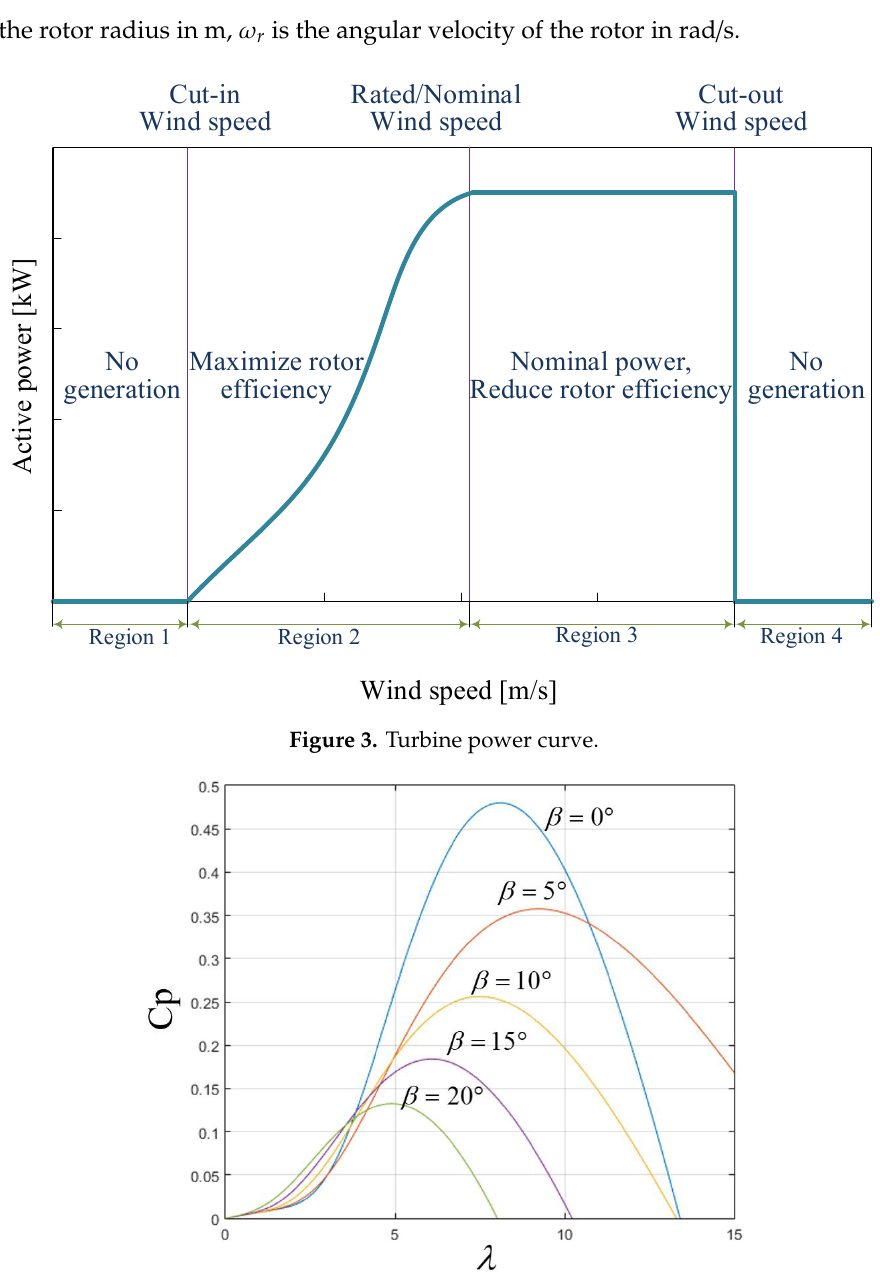
Figure 4. Power coe ffi cient with respect to tip speed ratio and pitch Figure 4. Power coefficient with respect to tip speed ratio and pitch angle. Figure 4. Power coefficient with respect to tip speed ratio and pitch angle.